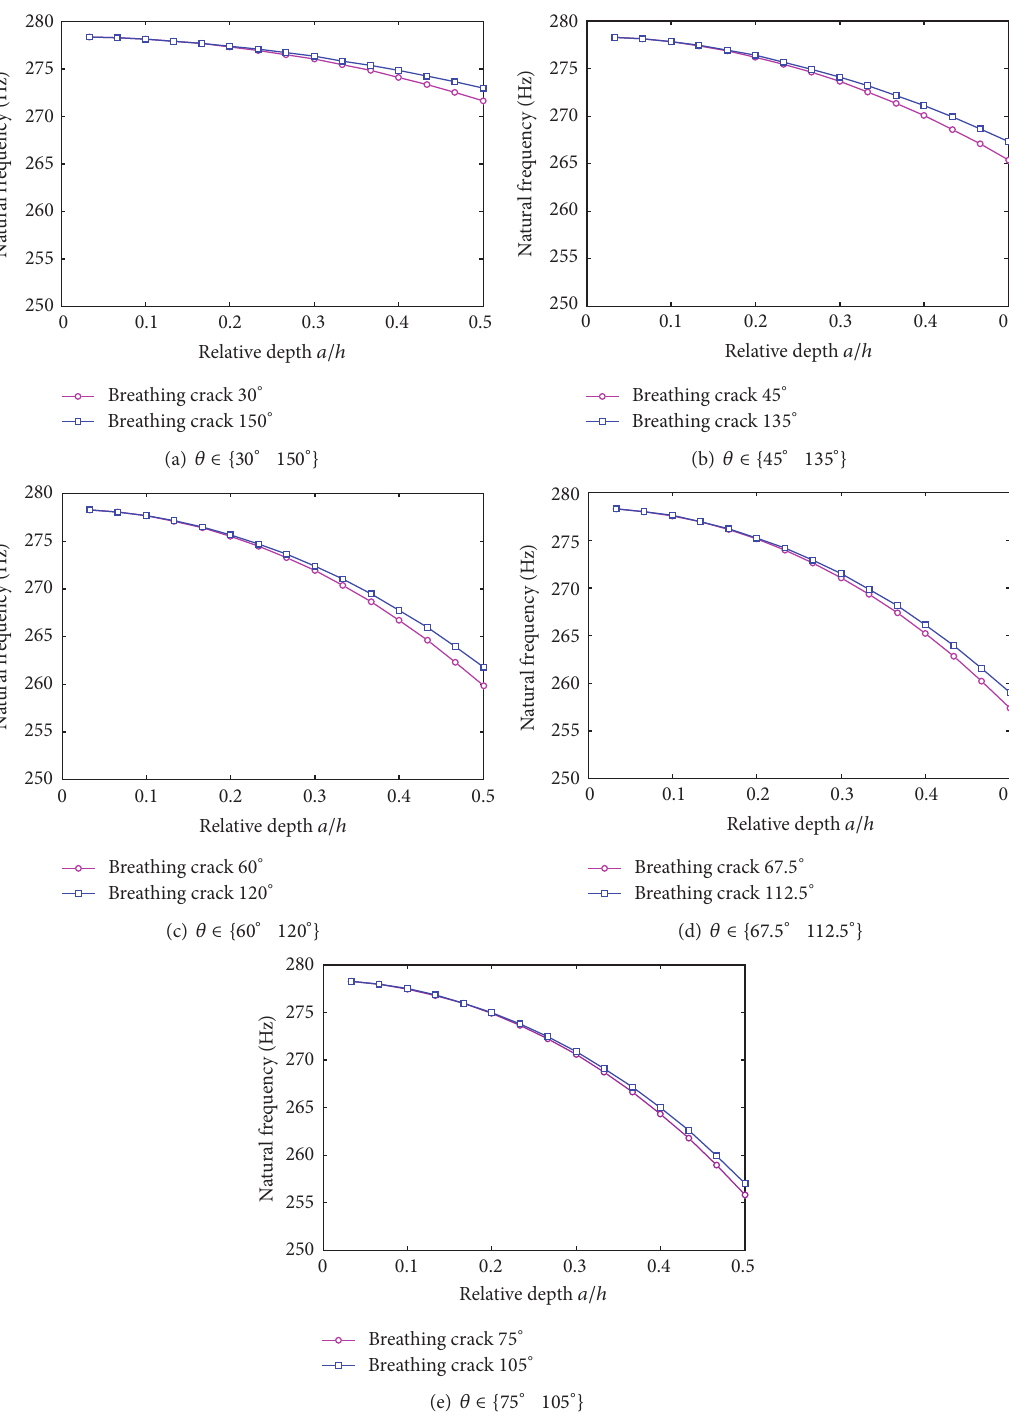
The modal analysis of the cantilever beam with a breath- ing oblique crack is carried out in this paper, and the possibility is provided for developing the structural health monitoring system of the beam with an oblique crack.